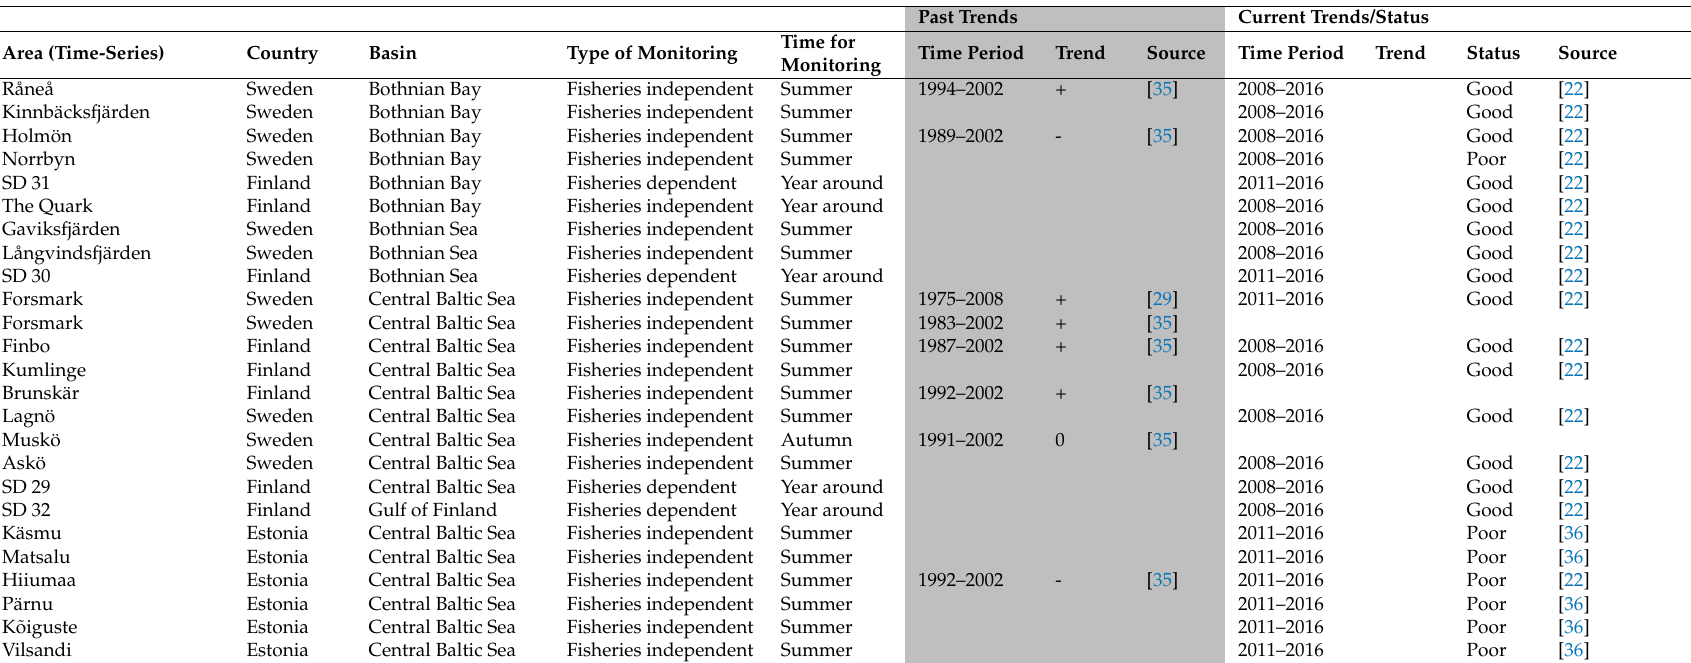
Table 2. Overview of the data and time-series used to assess past (data until the 2000s, grey columns) and current (data until the 2010s white columns) trends and status for perch. The columns “Source” refers to reference